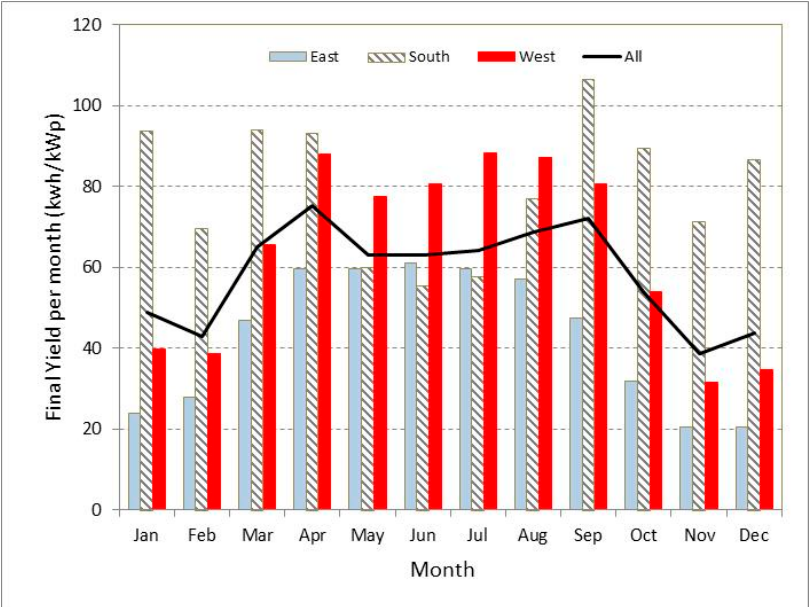
Figure 8. Final Yield of each façade and of the total PV installation, in hours (kWh/kWp).